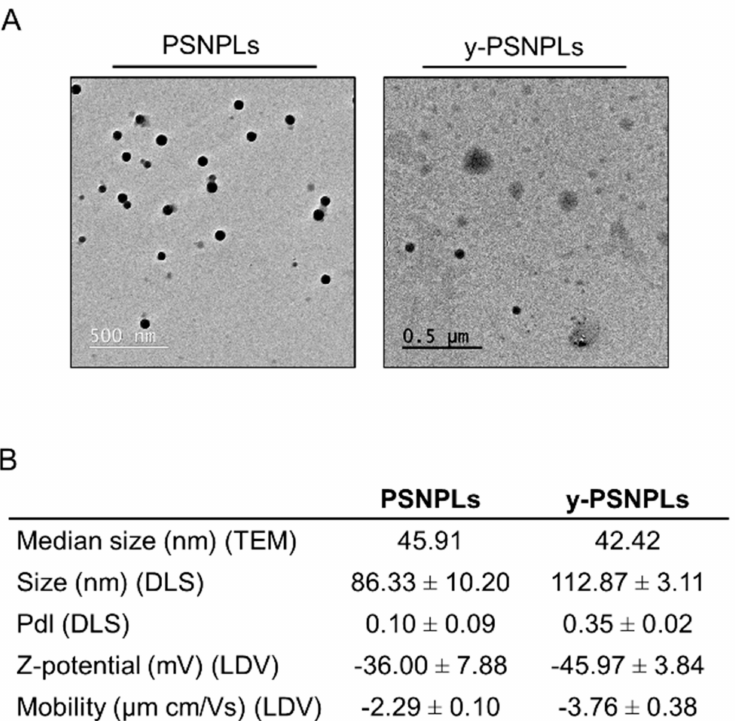
Figure 1. PS nanomaterials characterization. ( A ) Representative TEM images of PSNPLs and y- PSNPL. ( B ) PSNPLs and y-PSNPLs characterization by TEM (median size calculated measuring 100 randomly selected PSNPLs) and Zetasizer Nano ZS (mean ± SD). 100 µ g/mL dilutions in distilled water of each material were used for the visualization and